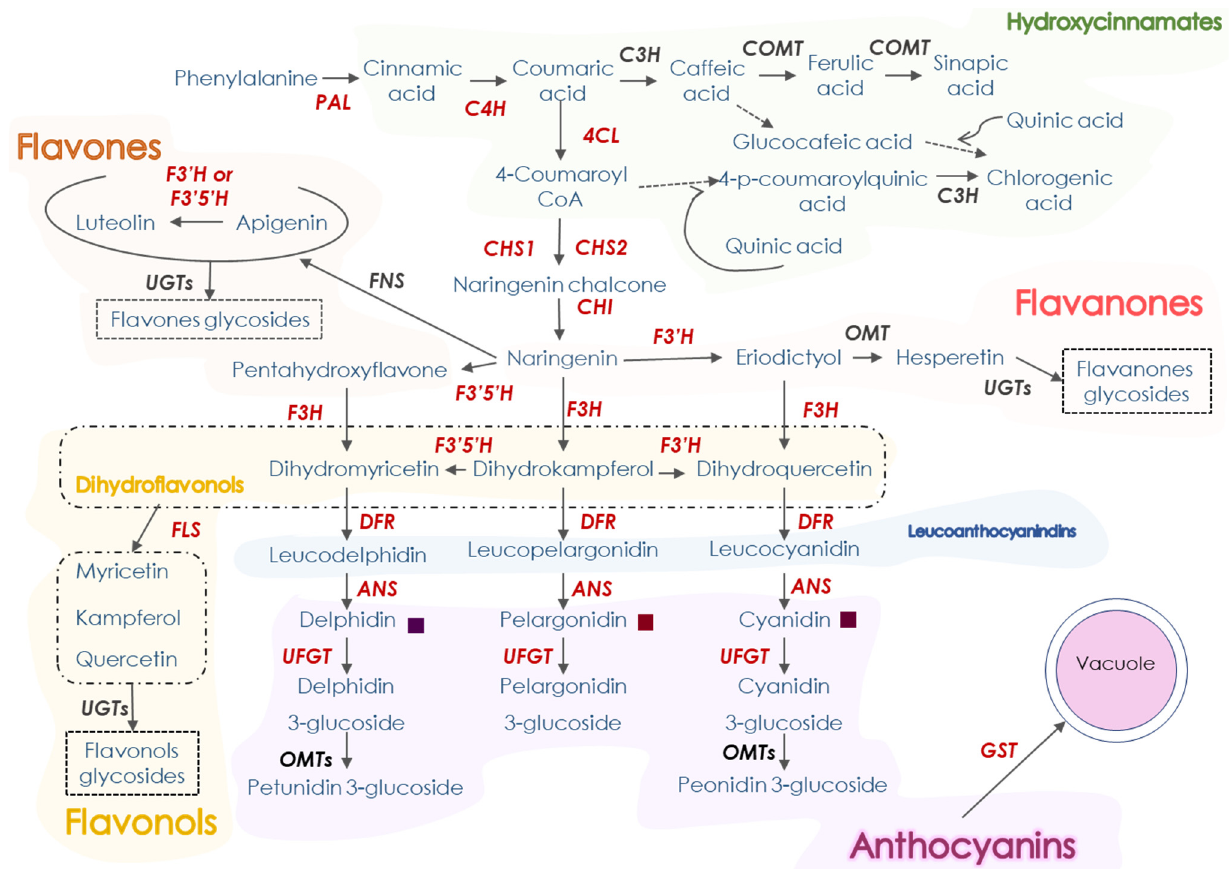
Figure 1. A schematic representation of the phenylpropanoid pathway. Red-bold labelled genes are those studied in this work. Gene names are abbreviated as follows: PAL , phenylalanine ammonia-lyase ; C3H , p-coumarate 3-hydroxylase , C4H , cinnamate 4-hydroxylase ; 4CL , 4-hydroxy-cynnamoyl CoA ligase ; CHS , chalcone synthase ; CHI , chalcone isomerase ; COMT , caffeic acid 3-O-methyltransferase ; FNS